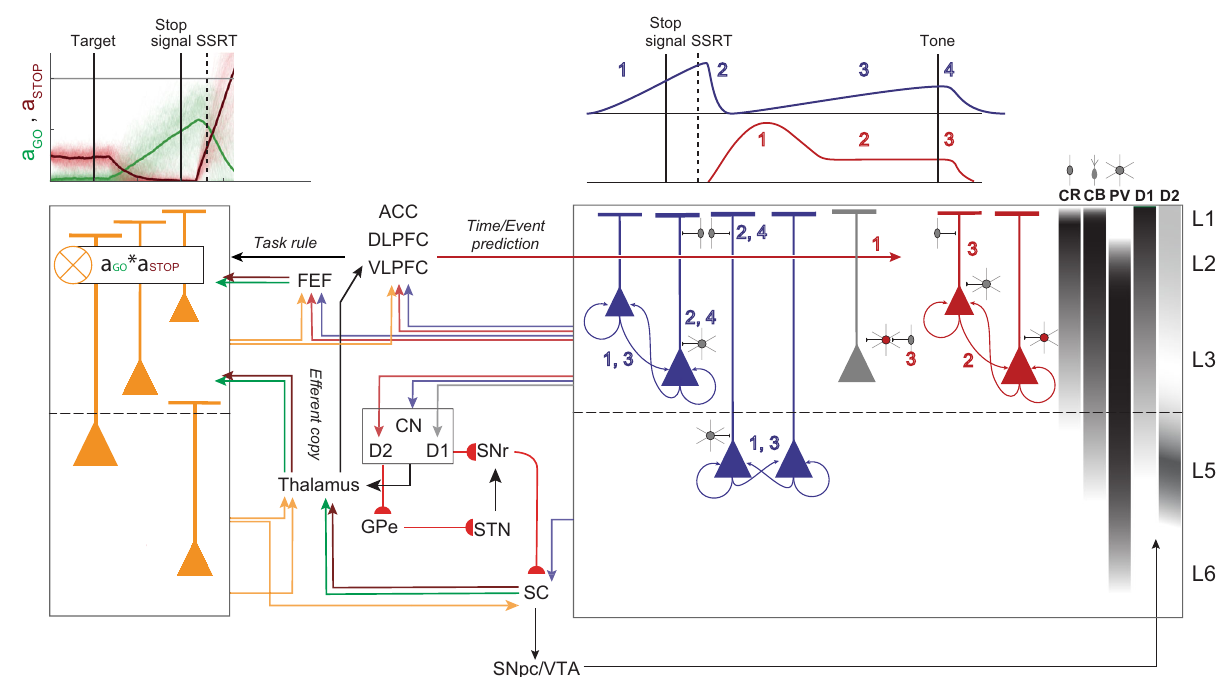
Fig. 7 | Executive control circuitry. Con fl ict (orange), Event Timing (dark blue), and Goal Maintenance (dark red) neurons are illustrated with selected anatomical connections and laminar densities of calretinin (CR), calbindin (CB), and parval- bumin (PV) neurons 21 and of D1 and D2 receptors 72 (right). Dopamine projections fromSNpcandVTAmodulateallcomputationsinSEF. Left ,Con fl ictsignalcanarise through coincident inputs of gaze-holding (STOP, dark red) and gaze-shifting neurons (GO, green) directly from FEF and indirectly via thalamus from SC termi- natinginL2andL3.Con fl ictsignalsintegratedacrossapicalandbasaldendritescan be sent to multiple cortical and subcortical structures. Right , Schematic pro fi les of Event Timing and Goal Maintenance activity with numbered phases. Event Timing neurons can receive inputs from DLPFC and ACC informing them about an upcoming event. Ramping results from recurrent connections (1, dark blue). SEF can receive information about the stop-signal appearanceand successful stopping from VLPFC and DLPFC and from Con fl ict neurons. This signal can suppress the ramping activity via inhibitory connections onto Event Timing neurons (2,